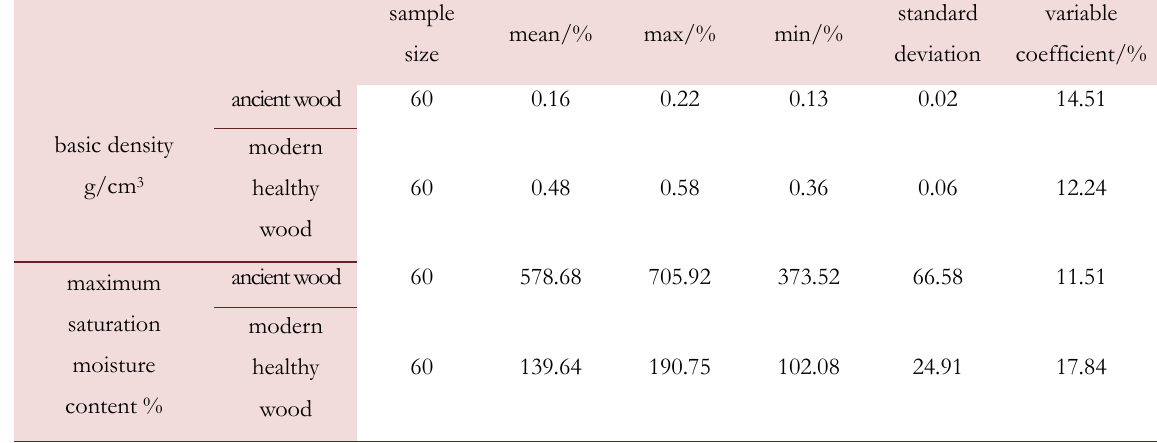
Table 1: Maximum moisture content, basic density and oven dry porosity of Pinus yunnanensisancient wood and healthy wood. Shrinkage, swelling and water